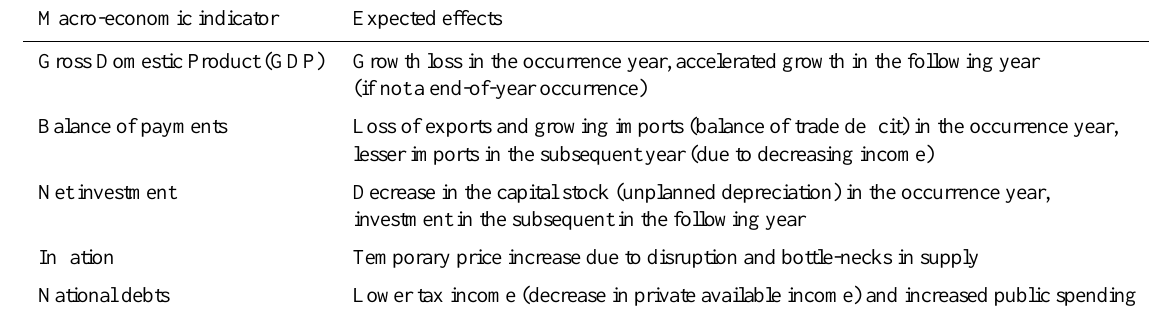
Table 9. Macro-economic indicators and expected